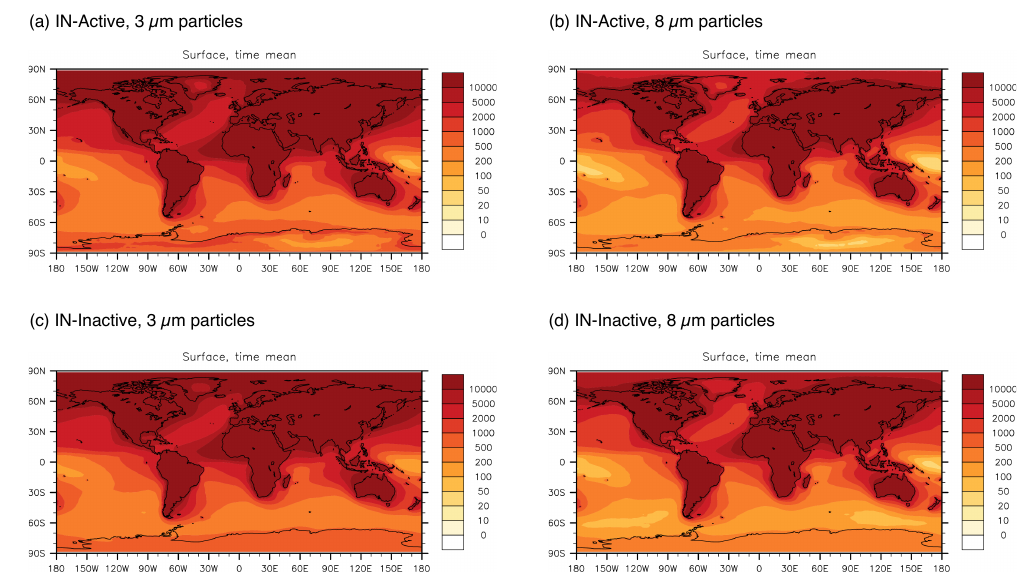
Figure 9. Annual mean spore concentrations (m − 3 ) at the surface in each global model simulation. (a) IN-Active, 3µm particles; (b) IN- Active, 8µm particles; (c) IN-Inactive, 3µm particles; (d) IN-Inactive, 8µm particles.